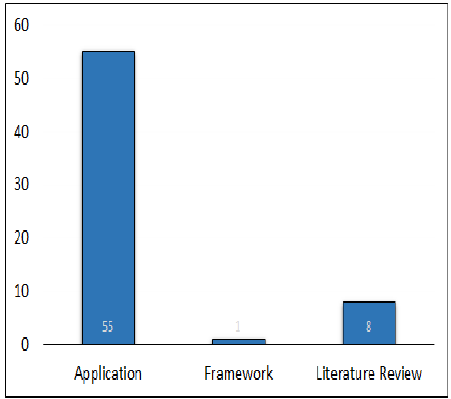
Figure 10. Article types and